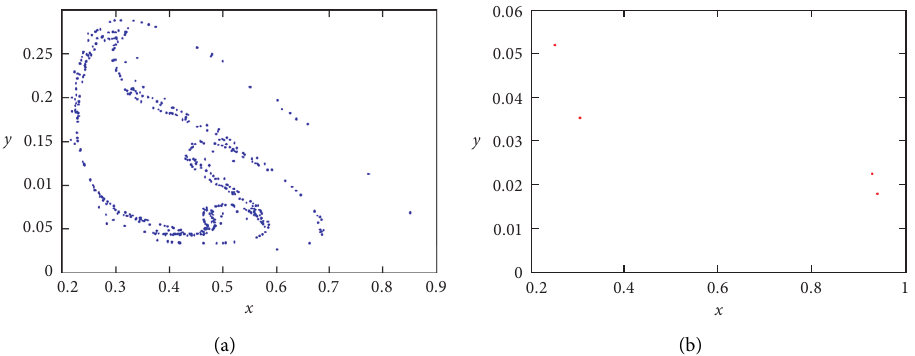
Figure 11: Poincar´e section of nonlinear chemical reaction with g � 0.09 and other parameters of Figure 10: (a) chaotic attractor for initial conditions (0.1, 0.1); (b) attractor of period 4 T for initial conditions (0.5, 0.5).